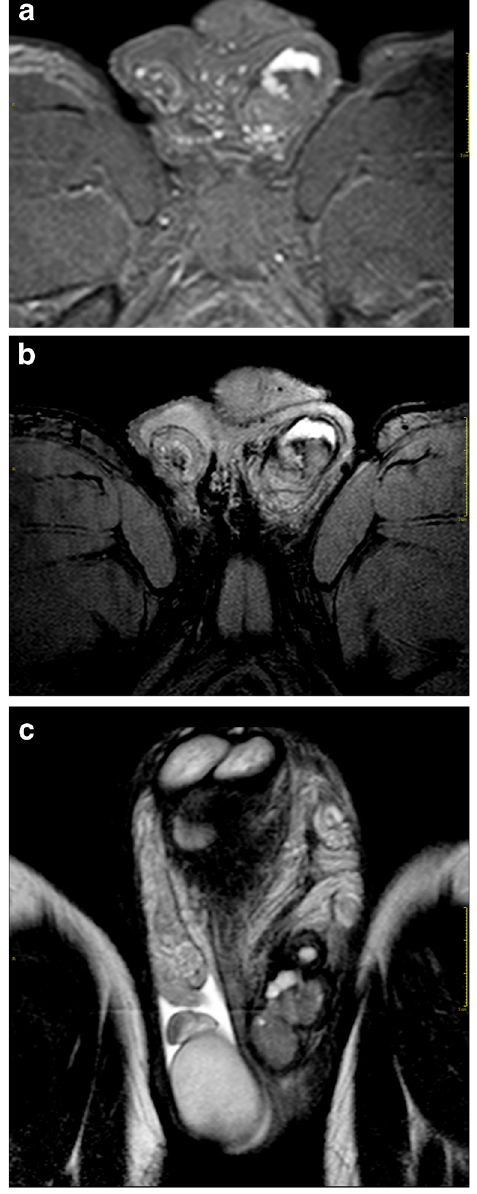
Fig. 1 a - c Left testicle rupture. MRI shows a tunica albuginea tear and testicle rupture. a T1-weighted SPIR TSE sequence, axial view, b T2- weighted FFE sequence, axial view; c T2-weighted TSE sequence, coronal view